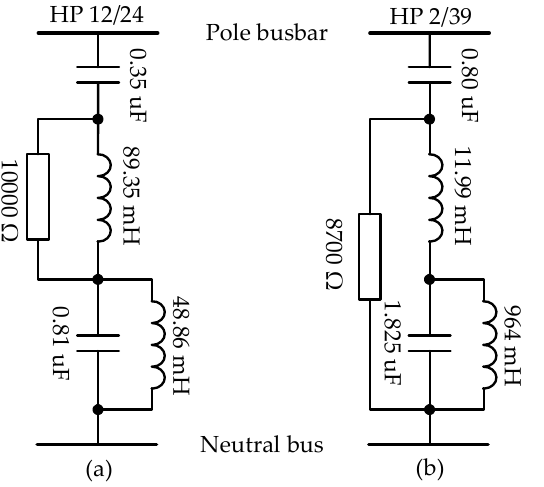
Figure 7. Schematics and parameters of the DCFs: ( a ) High Pass (HP) 12/24; ( b ) HP 2/39.